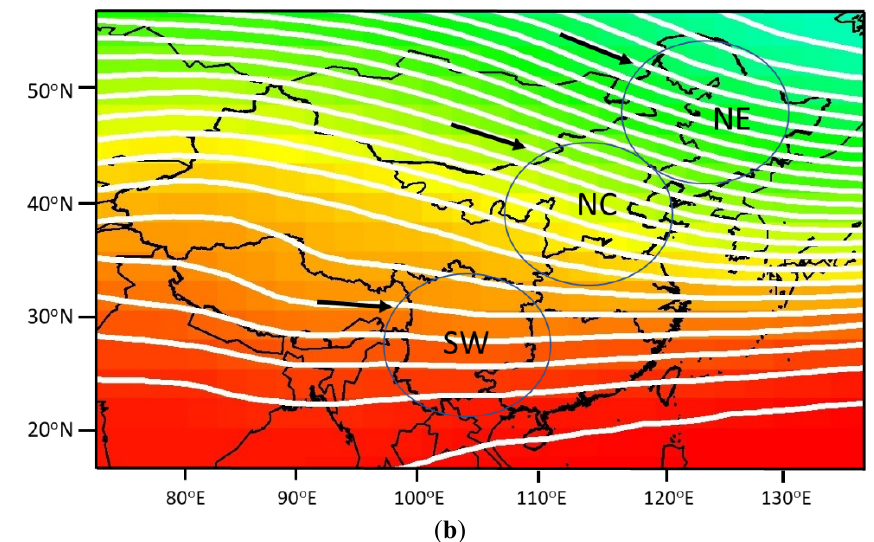
Figure 2. Population density ( a ) (from [28]) and atmospheric circulation in the 500 hPa geopotential height field; ( b ) (drawn using the data from the US National Centers for Environmental Prediction/Department of Energy Reanalysis-2 [34]).